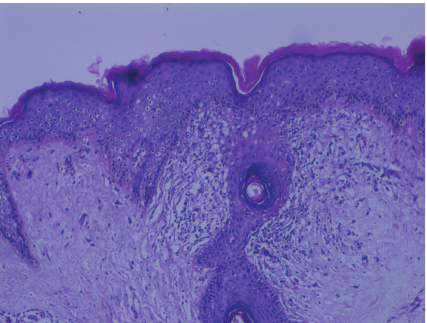
Figure 3: Hyperkeratosis, a keratotic plug in the follicular infun- dibulum, spongiosis, lymphocyte exocytosis, and perivascular and periadnexal lymphocytic